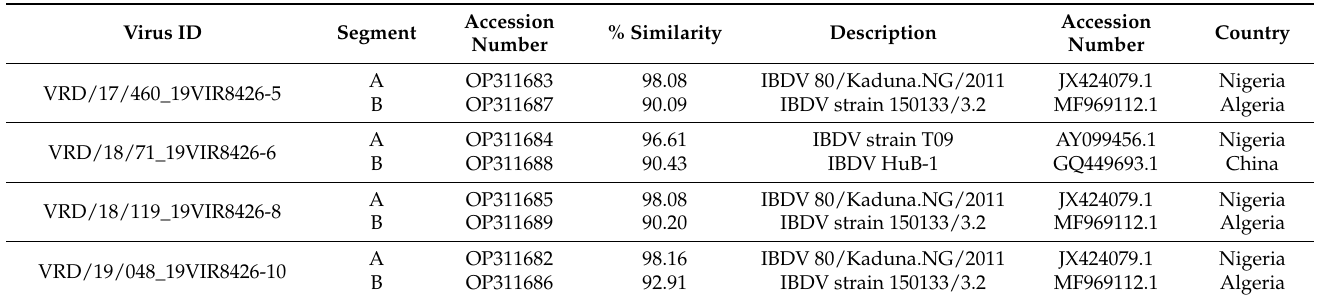
Table 2. Closest BLAST matches against NCBI database of IBDV segments A and